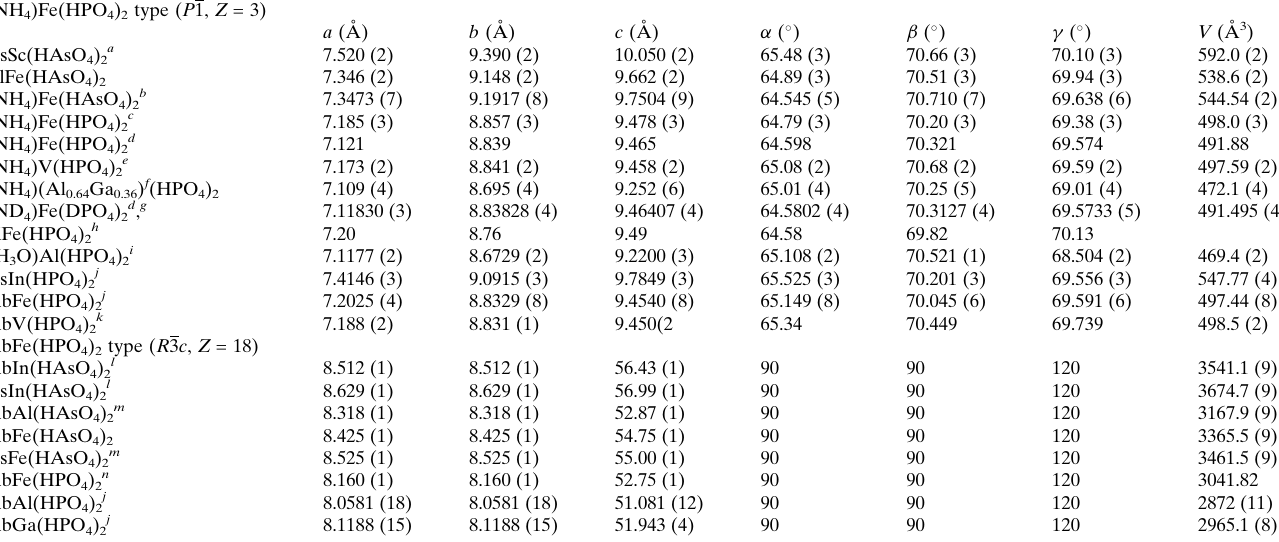
Table 1 Compilation of all published compounds adopting the (NH 4 )Fe(HPO 4 ) 2 structure type (Yakubovich, 1993) and the RbFe(HPO 4 ) 2 structure type (Lii & Wu, 1994).